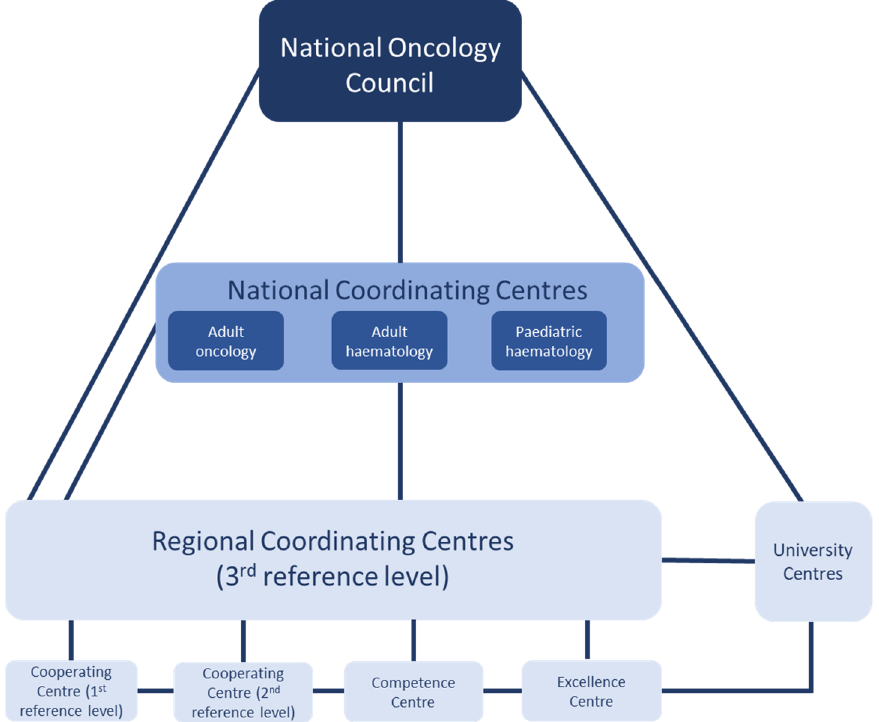
Figure 1. Proposed organization of the National Oncology Network, developed in 2018. Source: Authors based on [17] (p. 38).